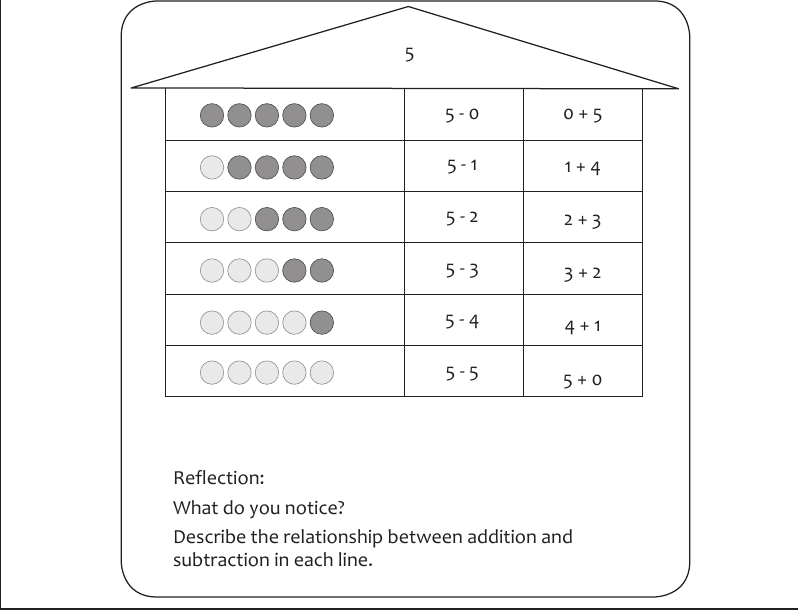
Figure 11: Complementarity of addition and subtraction